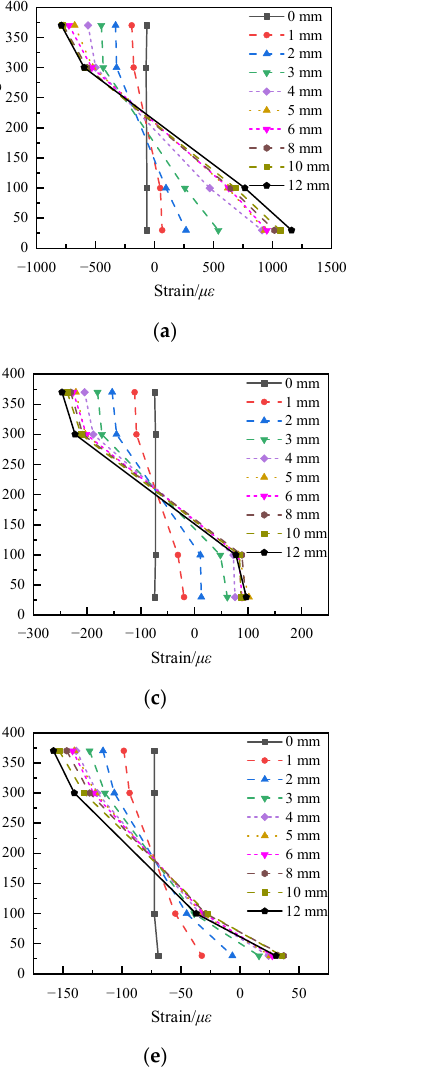
Figure 9. Strain distribution of each section. ( a ) S1 lower segment. ( b ) S2 lower segment. ( c ) S1 middle segment. ( d ) S2 middle segment. ( e ) S1 upper segment. ( f ) S2 upper segment.